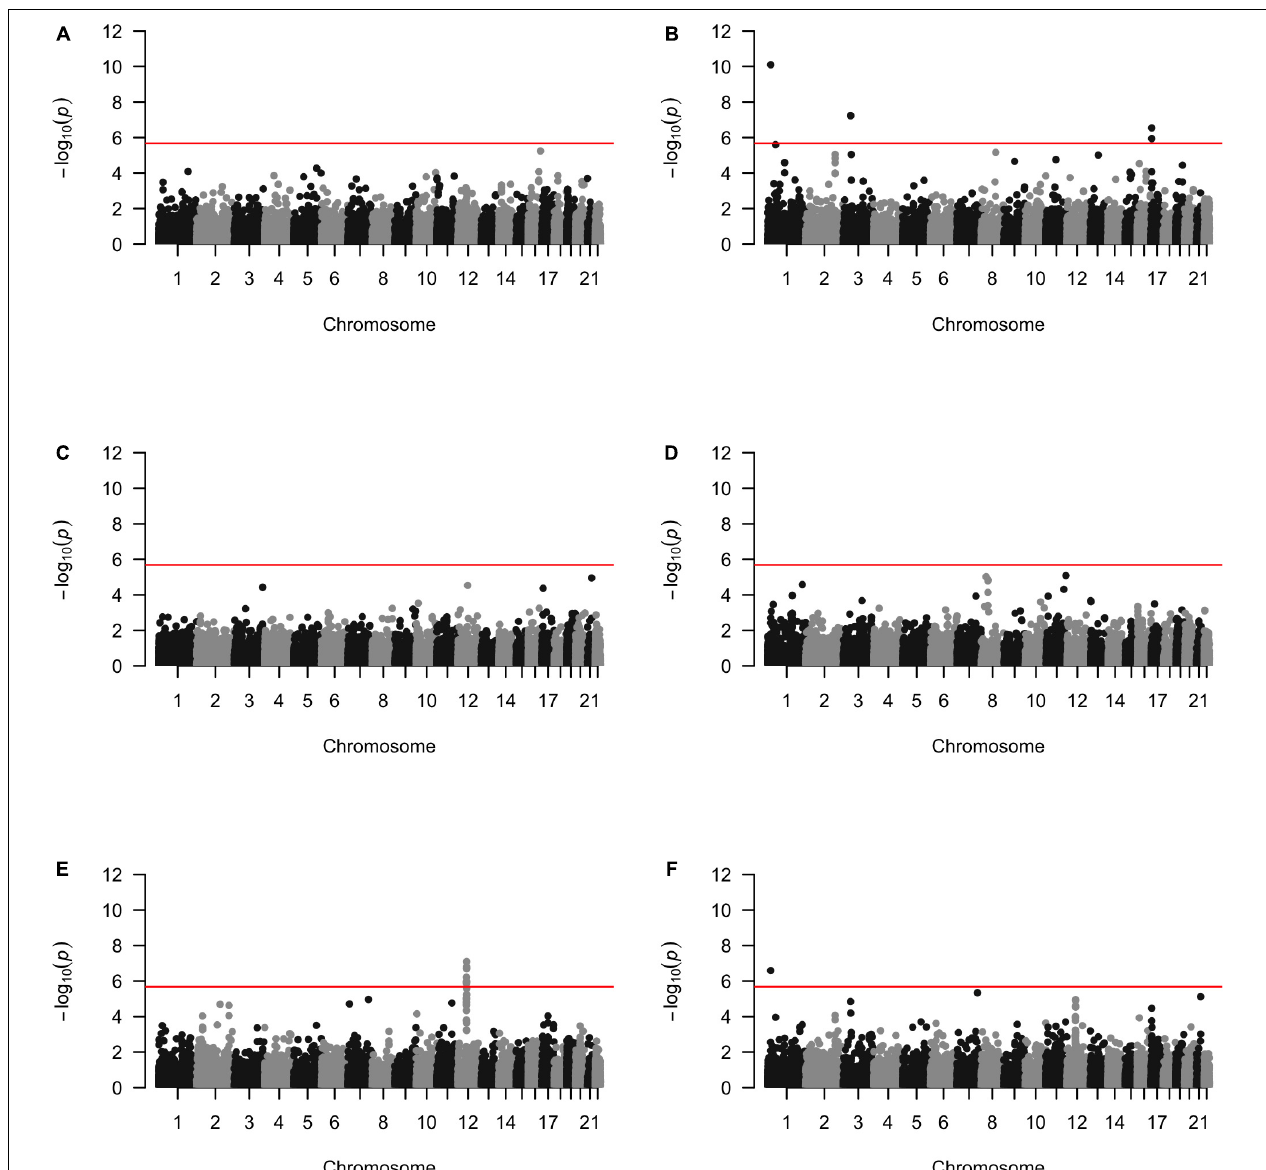
FIGURE 4 | The Manhattan plots by all variants analysis in each population (A) Affymetrix. (B) Illumina. (C) OmniExpress. (D) OncoArray. (E) HumanCore. (F)